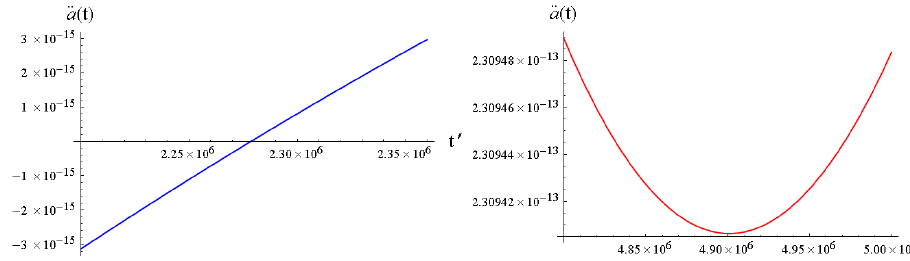
Figure 2. Inflation entry times for p = 2 and p = 3.